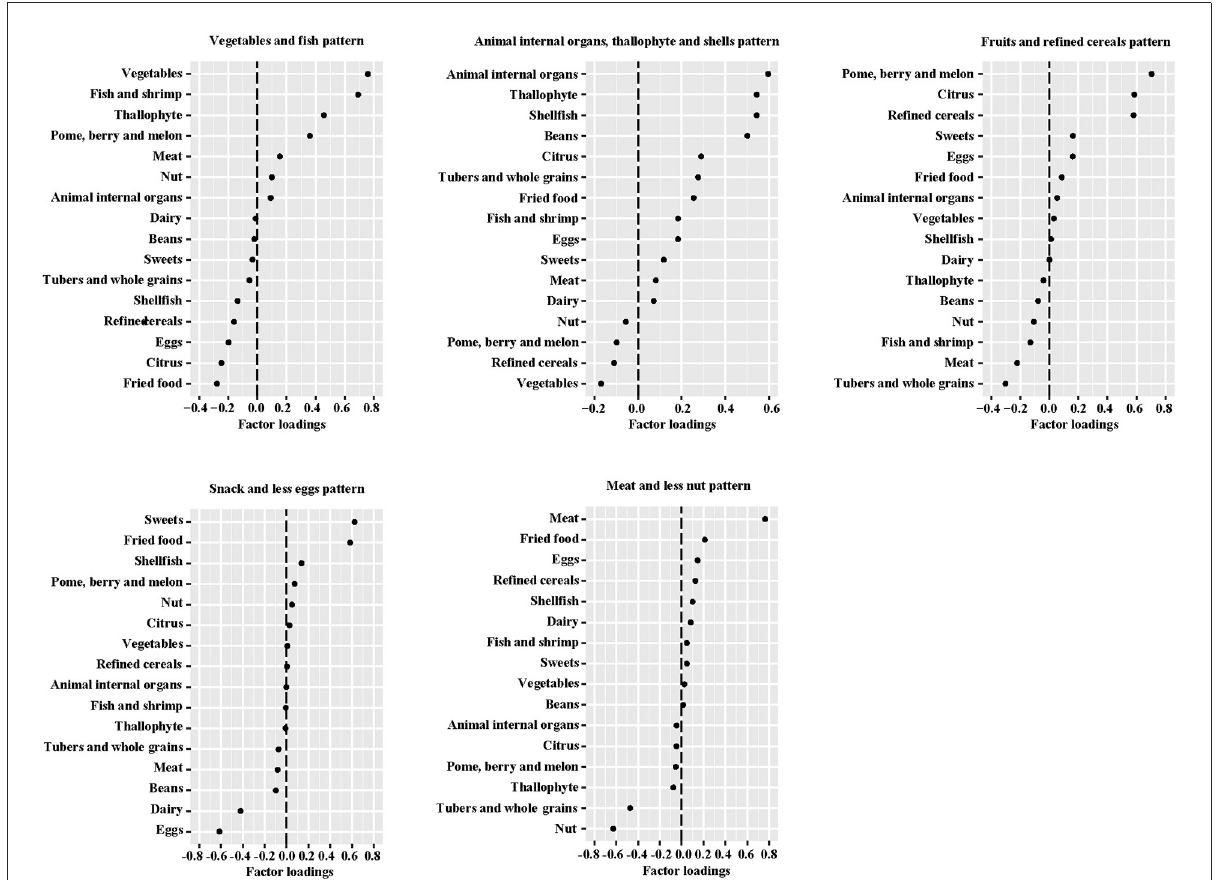
FIGURE1 Factor loadings of averaged* food groups in middle and late pregnancy for five dietary patterns. *The geometric mean of food groups in two trimesters of pregnancy.